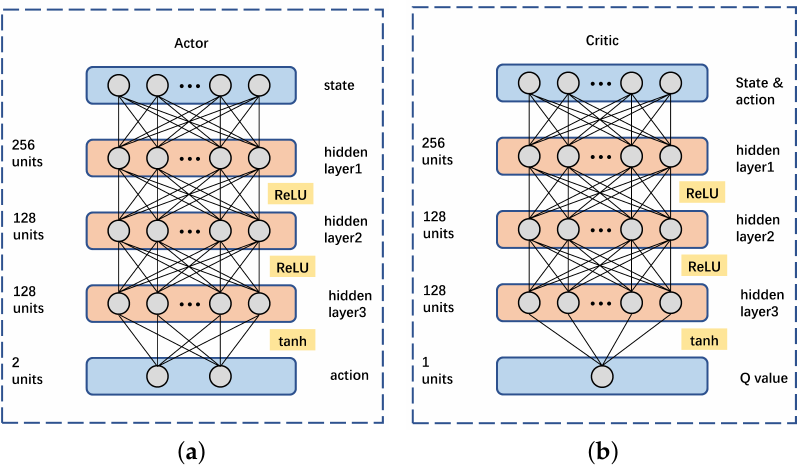
Figure 11. Illustration of the neural network design of the actor and critic framework. ( a ) represent the actor network structure and ( b ) represent the critic network structure.